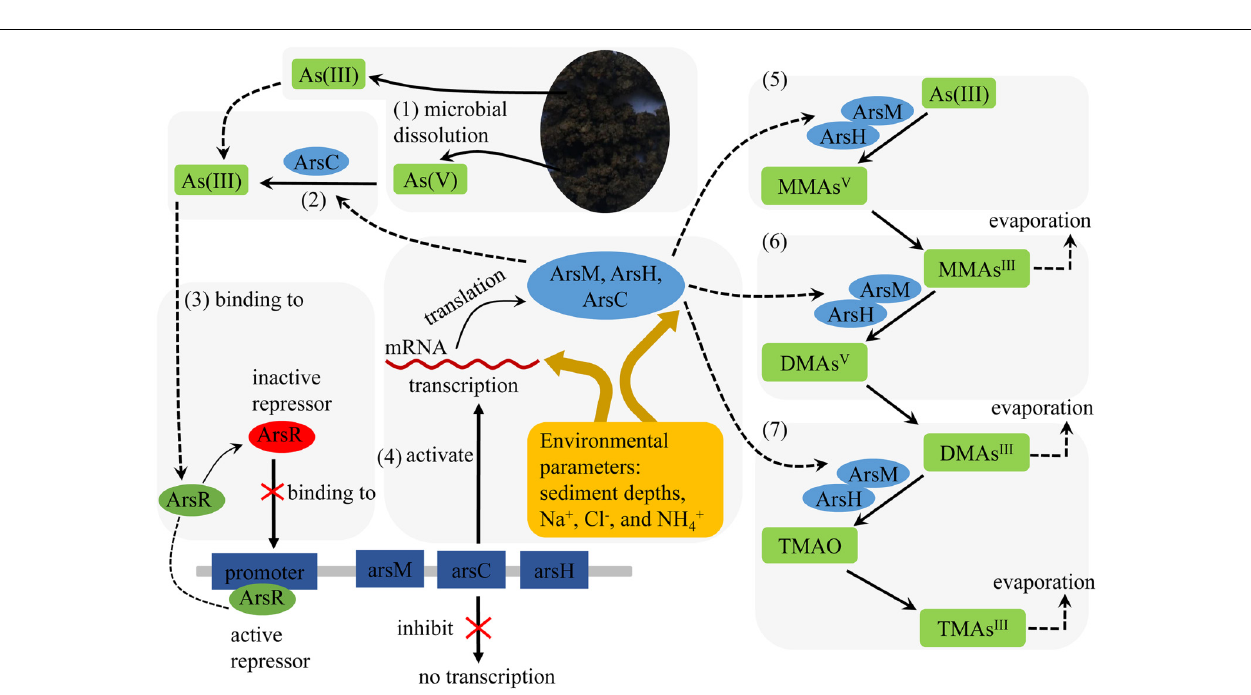
FIGURE 6 | A comparison between the As-methylating activities in the presence and absence of exogenous As and organic carbon.